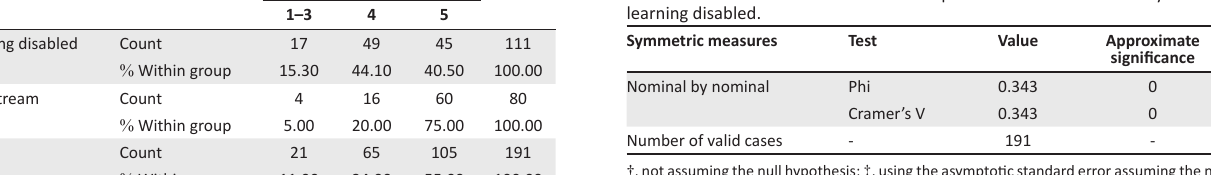
TABLE 2: The prevalence of saccadic (accuracy) in the mainstream and the learning-disabled groups. Crosstab Prevalence